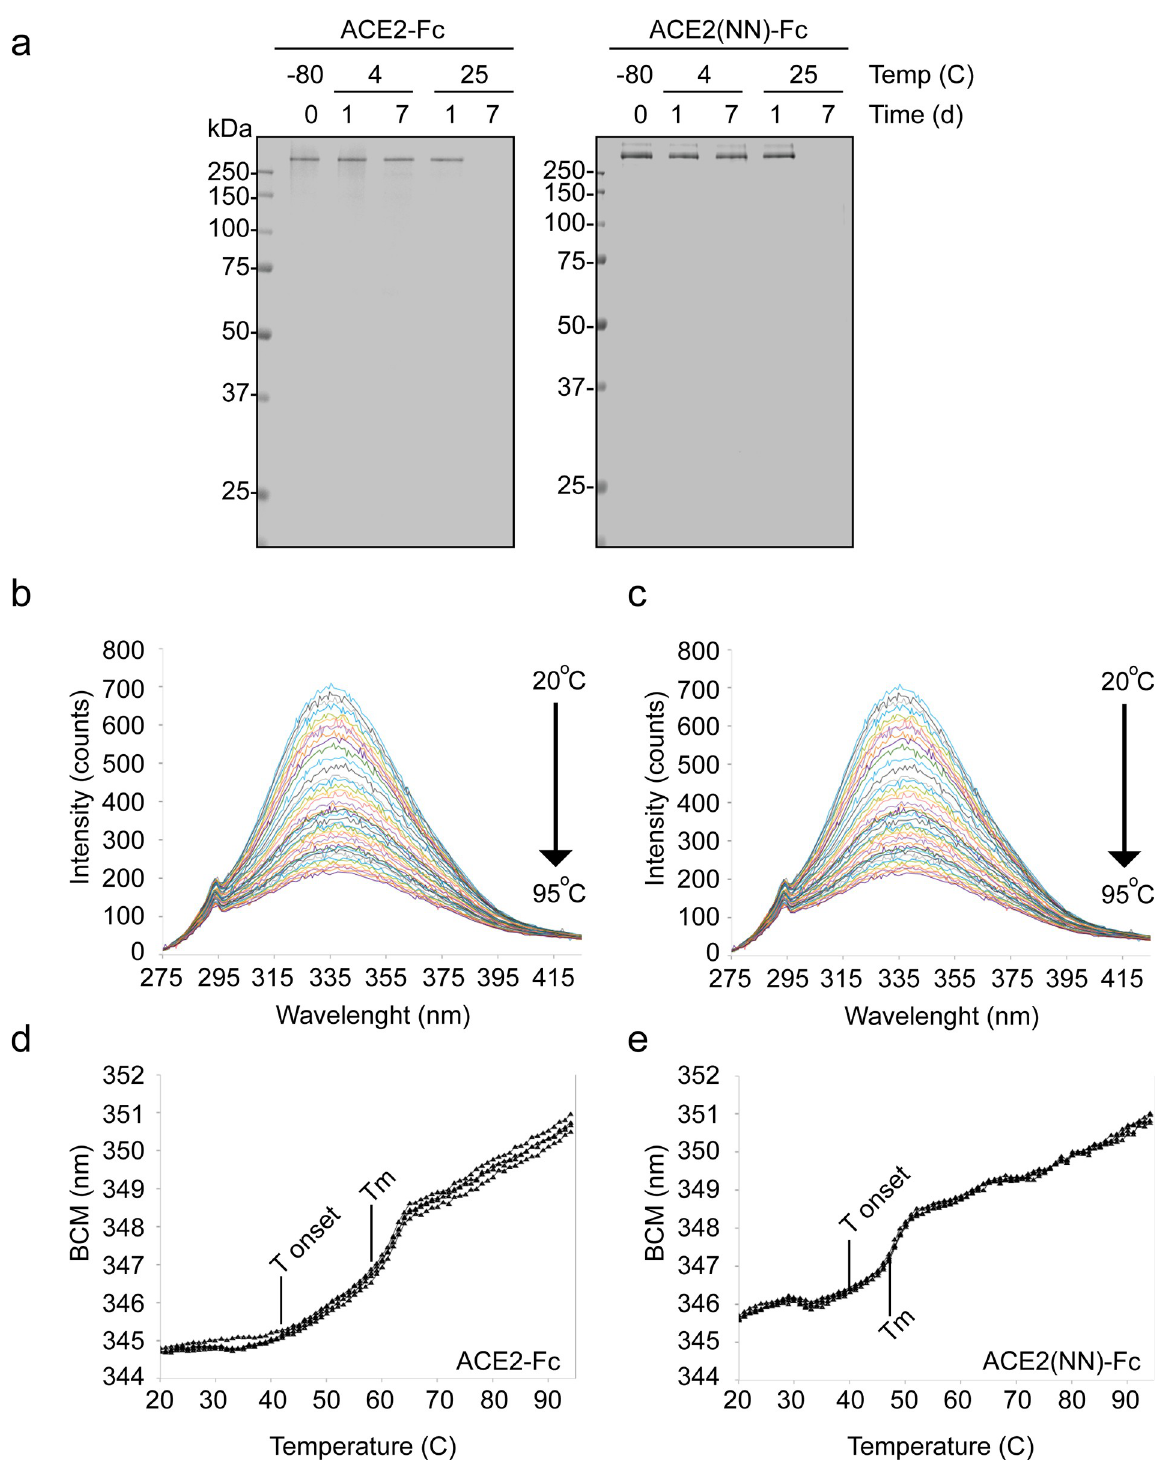
Fig 4. ACE2-Fc and ACE2(NN)-Fc thermal stability assessment. ( a ) Non-reduced Coomassie-stained SDS-page gels of the ACE2-Fc fusion proteins (1.5 μ g) in the storage condition (-80˚C) and at 4˚C and 25˚C for 1 and 7 days. Representative spectra of intrinsic fluorescent intensity curve changes of ACE-Fc ( b ) and ACE2(NN)-Fc ( c ) over a 20˚C to 95˚C temperature range at 1˚C increments. The barycentric mean (BCM) of the intrinsic fluorescent curves was plotted against the temperature to determine onset of protein unfolding (T onset) and melt temperature (Tm) of ACE2-Fc ( d ) and ACE2(NN)-Fc ( e ). One batch of each ACE2 fusion protein was analyzed in quadruplicate (n = 4).